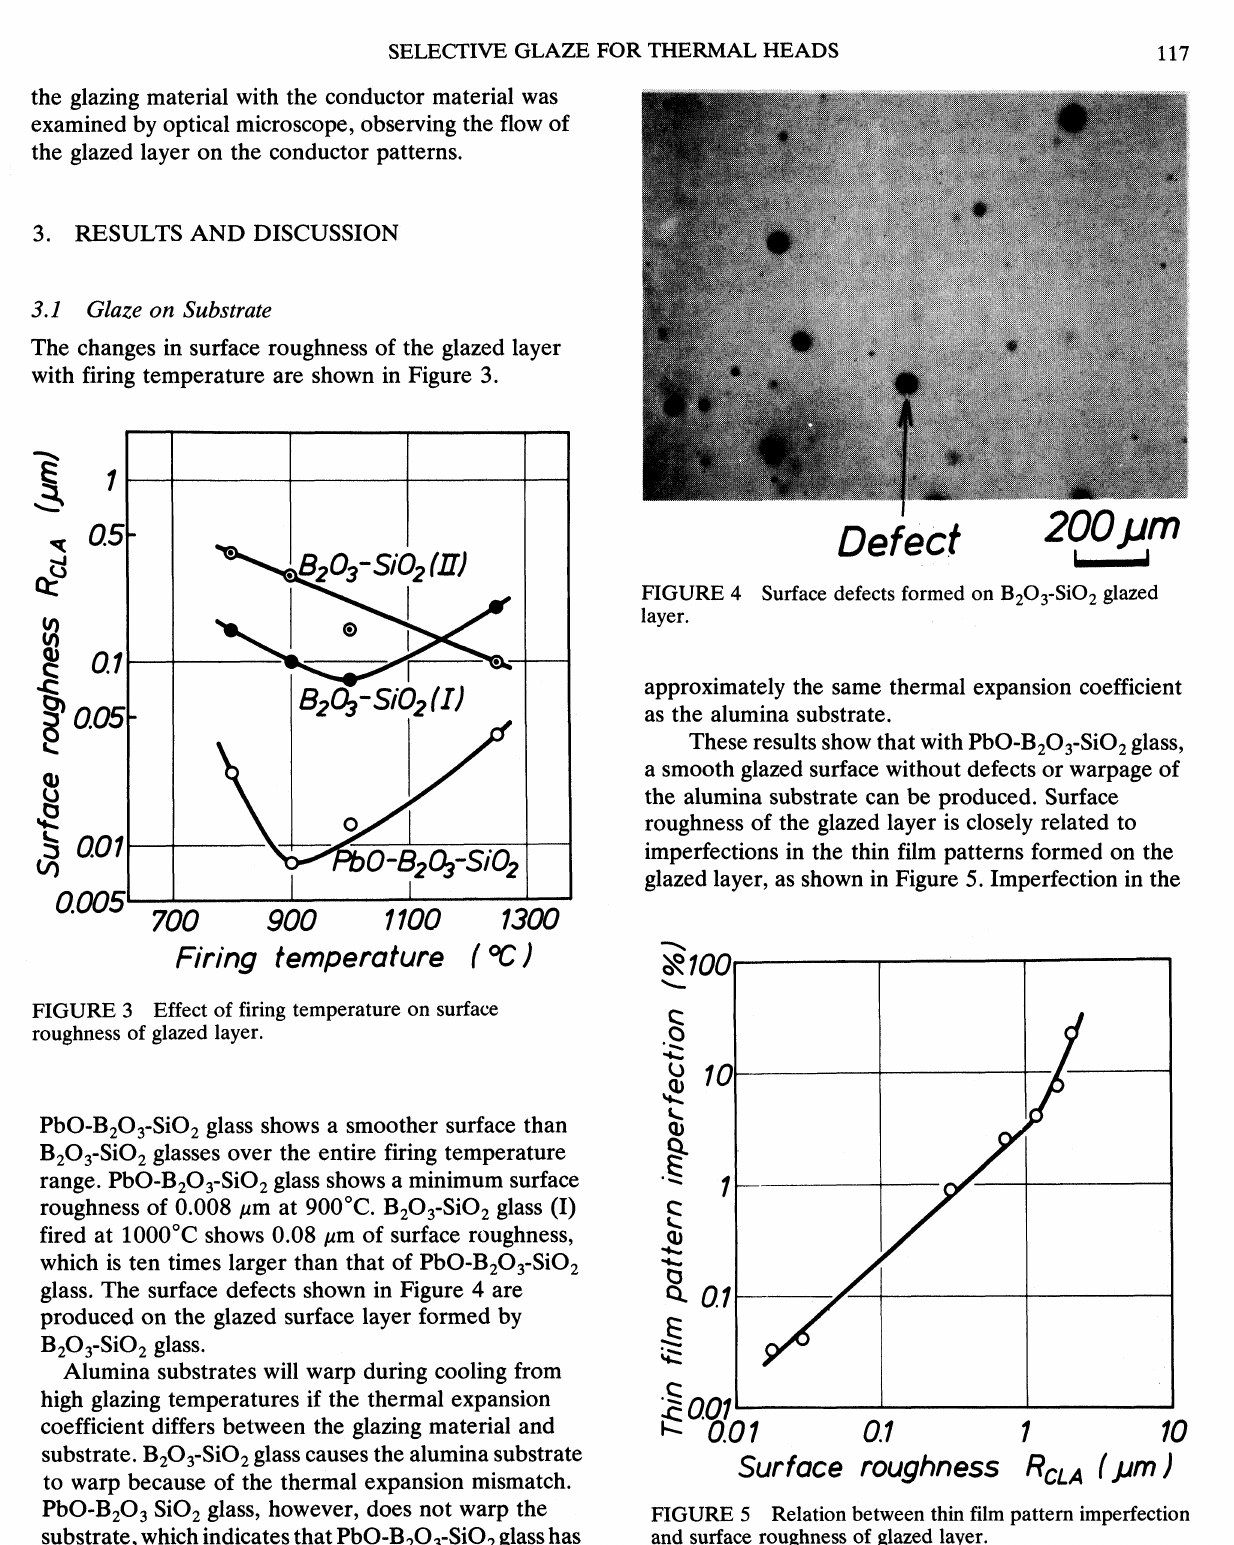
FIGURE 5 Relation between thin film pattern imperfection and surface roughness of glazed